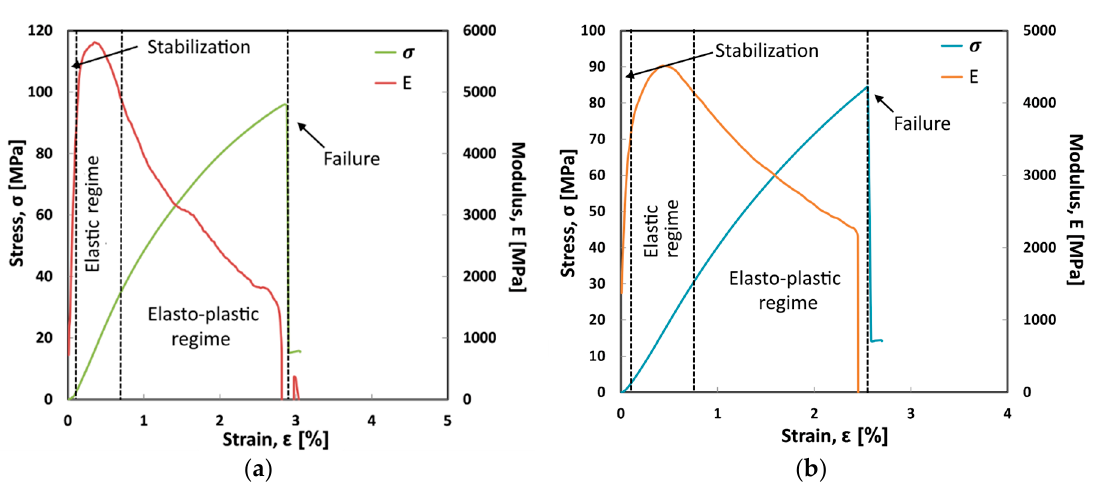
Figure 3. Flexural stress and modulus vs. strain typical curves of ( a ) Flax-T and ( b ) Jute-T laminates.